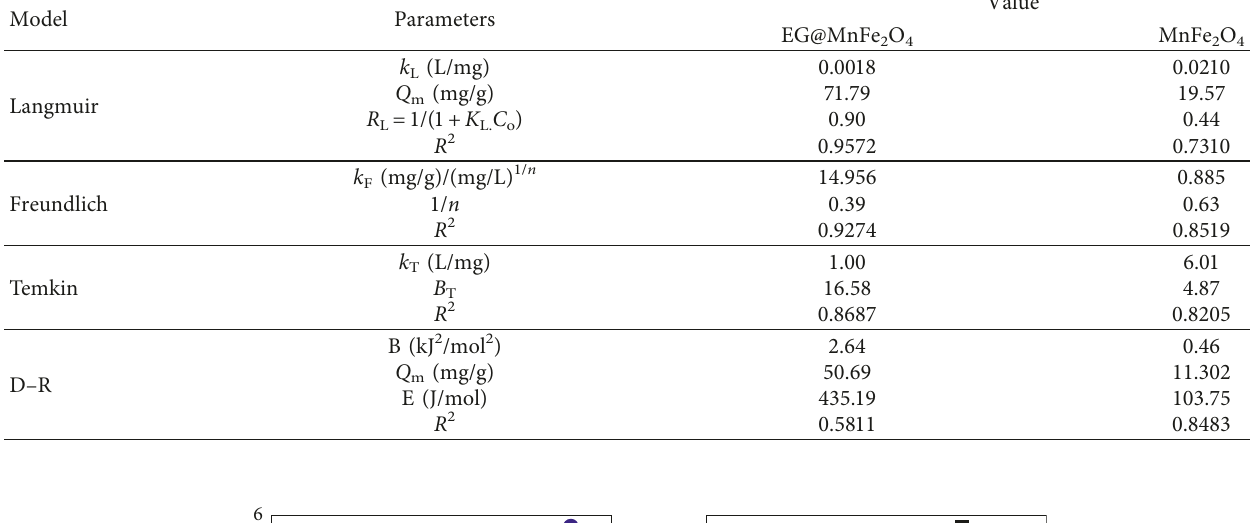
2 O 4 and MnFe 2 O 4 .